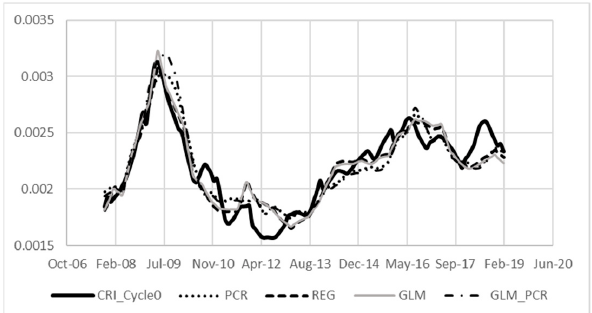
Figure 2. Fitted models for PCR, GLM-PCR, REG, and GLM against 𝐶𝑅𝐼′′ .